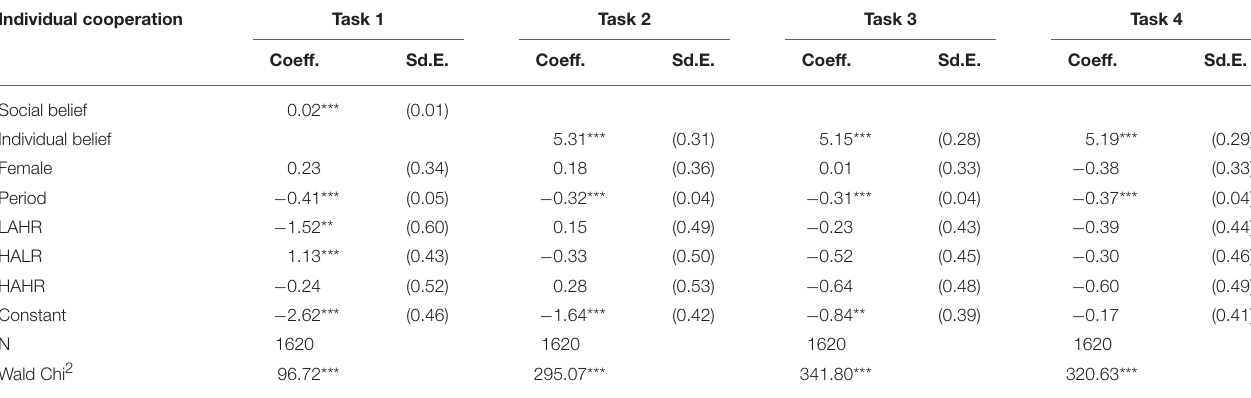
TABLE 5 | Random-effects panel logit regressions of individual cooperation on treatment, period and beliefs. Individual